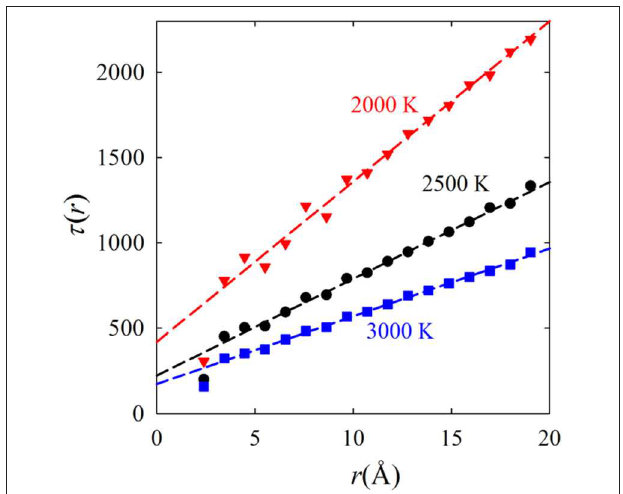
FIGURE 2 | Linear dependence of the decay time of the Van Hove function on distance, simulated for liquid Fe